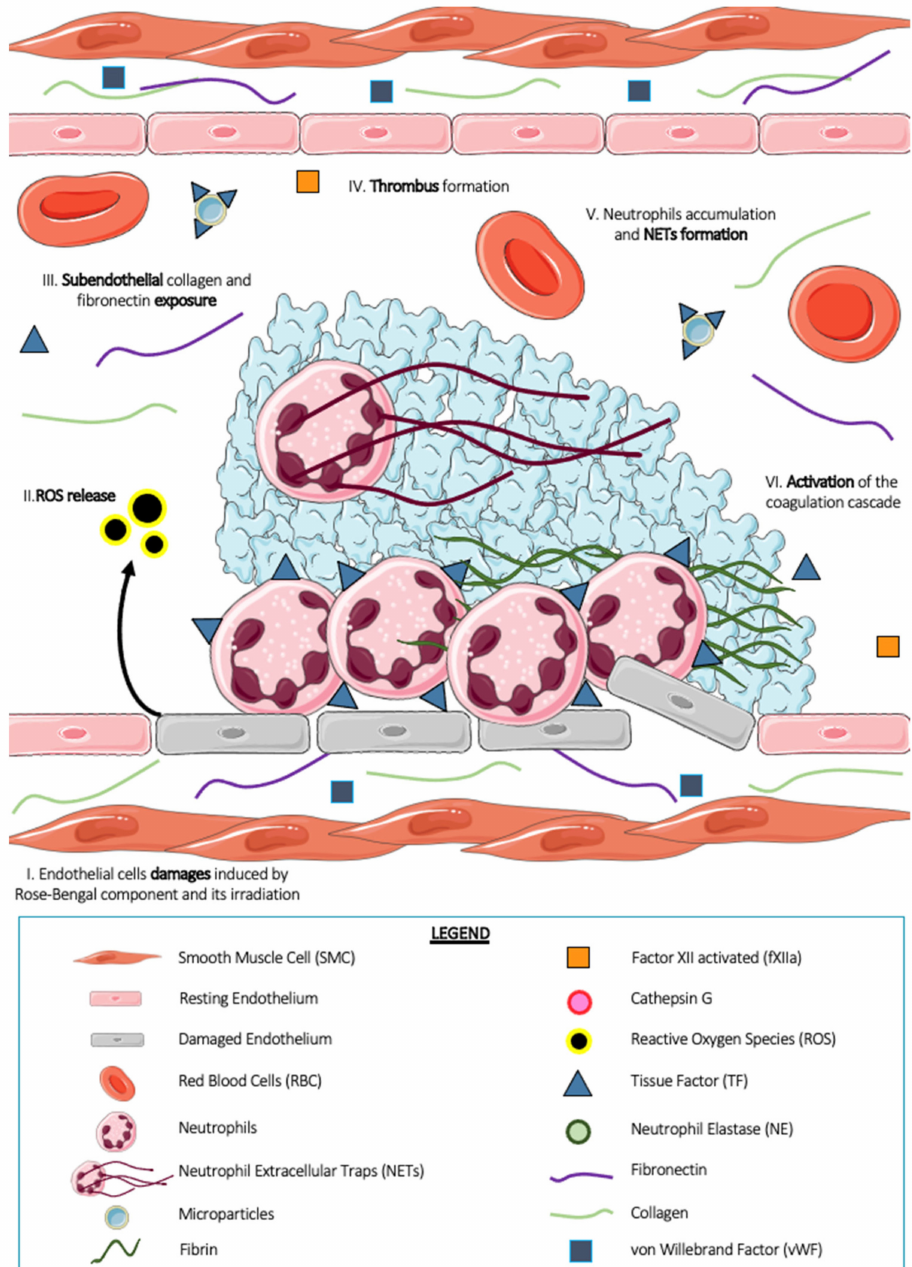
Figure 2. Thrombus formation after rose bengal photosensitization. The vessel wall is exposed to photosensitized rose bengal-induced phototoxicity, that leads to damage of the vascular endothelial cells (I) inducing permeability, loss of protein expression, release of reactive oxygen species (ROS) (II), which may even lead to cell death. This results in partial or complete denudation of the endothelium accompanied by the exposure of subendothelial collagen and fibronectin (III). These strongly pro- thrombotic compounds induce the formation of a thrombus (IV) in which leukocytes are identifiable (V). These leukocytes, like neutrophils, carry on their surface tissue factor (TF) responsible for the generation of fibrin in this model